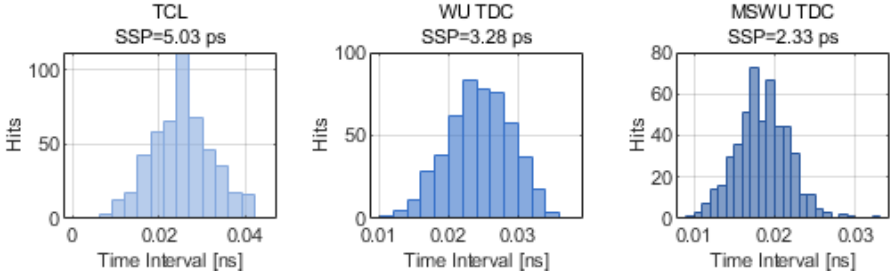
Figure 10. Single-shot precision test for different TDCs using a signal split into two channels.